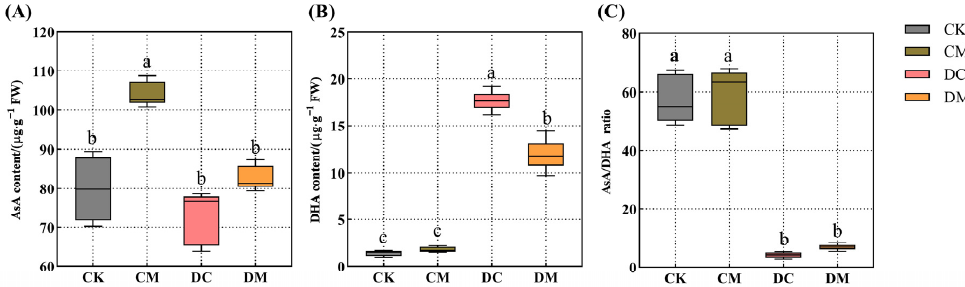
Figure 4. Effect of exogenous melatonin on ascorbic acid content under drought stress. ( A ) AsA content; ( B ) DHA content; and ( C ) AsA/DHA